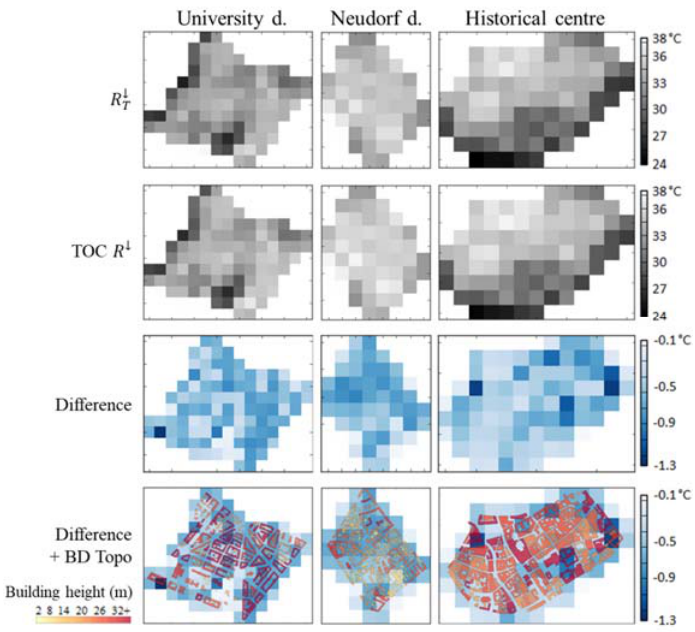
Figure 14. LST maps derived from ASTER for each district using total downwelling TIR radiation ( R ↓ , 1st row), top-of-canopy-downwelling TIR radiation (TOC R ↓ , 2nd row), the difference between both (3rd row) and difference between both + building footprints (4th row). Table 6. Maximum, mean and standard deviation of the difference between LST estimated using total downwelling TIR radiation or top-of-canopy-downwelling TIR radiation for each district. University District Neudorf District Historical